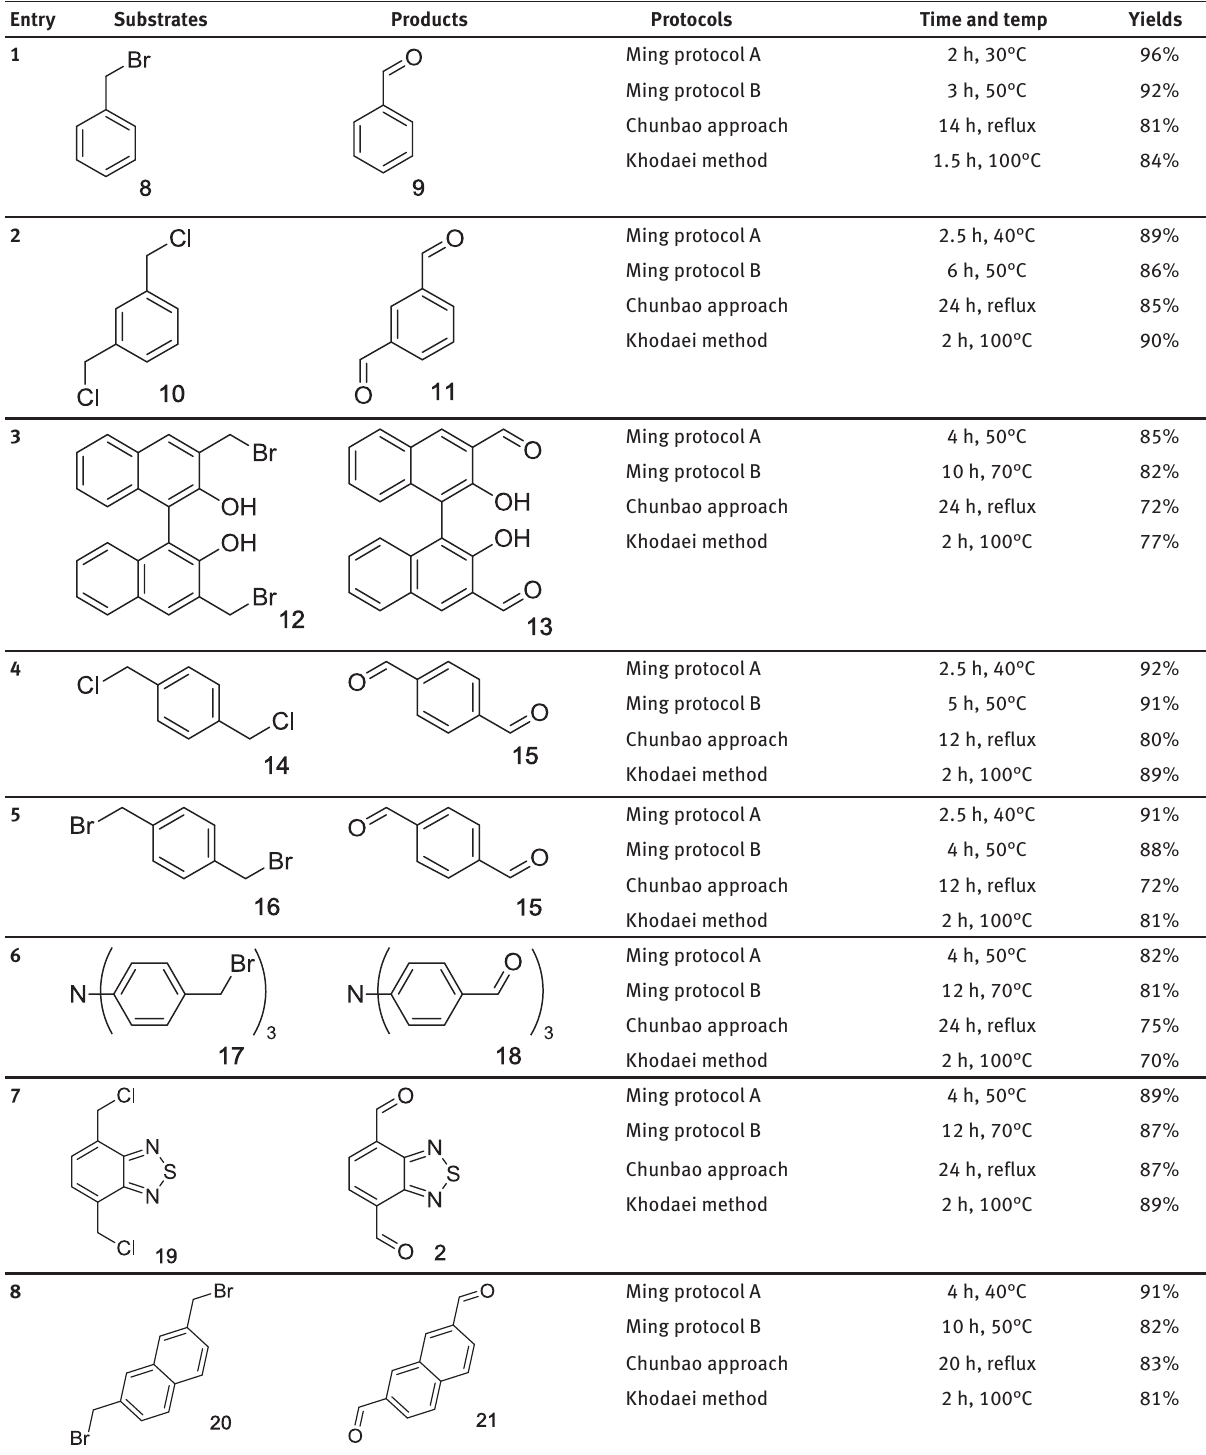
Table 3: Application of selected oxidative protocols for synthesis of dialdehydes.